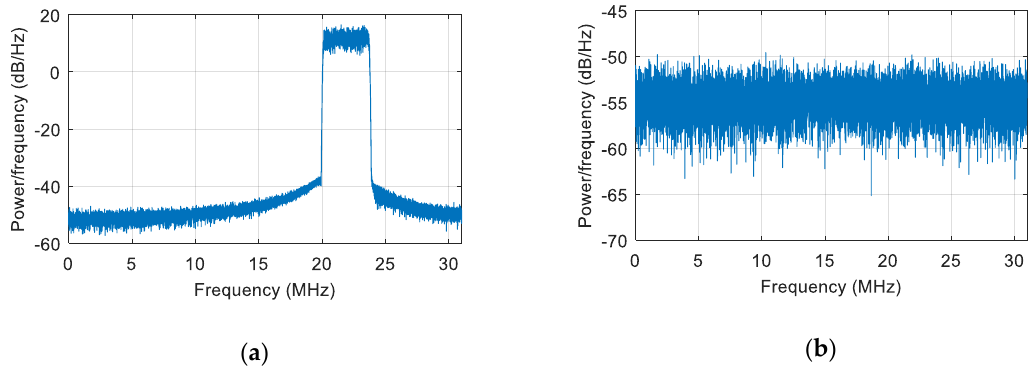
Figure 6. The power spectral density of the signal. ( a ) The power spectral density of the signal before interference suppression; ( b ) the power spectral density of the signal after interference suppression.